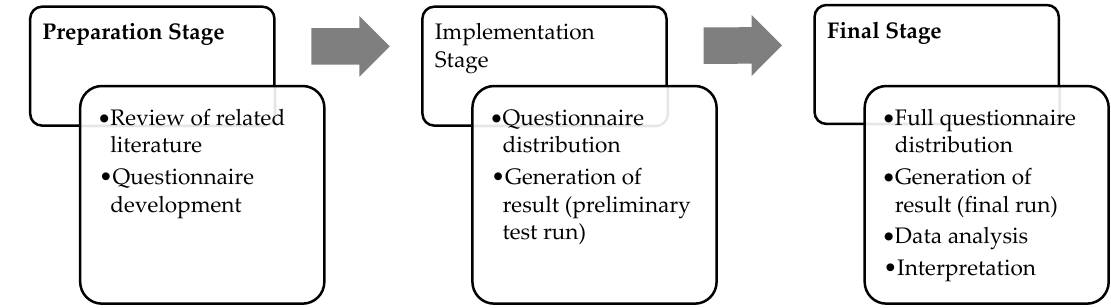
Figure 2. The research conceptualization.